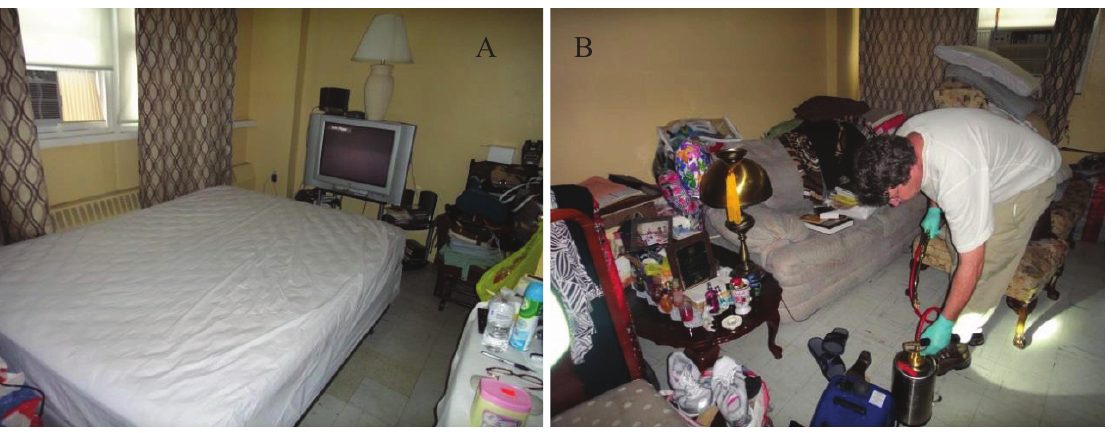
Figure 1. A typical test apartment. ( A ) bed area; ( B ) living area with a researcher using a B and G